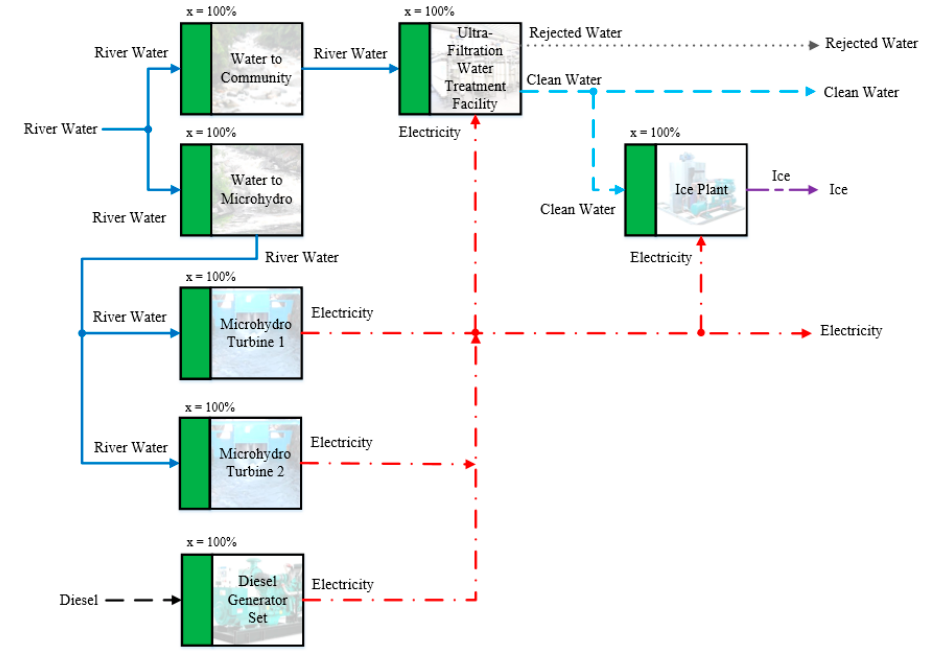
Figure 8. The process flowsheet of the polygeneration system of case study 3. The optimal operational adjustment results for case study 3 using various levels of D is shown in Table 6. The table shows the dynamic operational capacity of the 2 micro-hydro turbines through varying drought intensity levels. It can be observed that turbine 2 will shut off at drought intensity levels of D = 0.40 and 0.50 and will operate again at D = 0.70 and Table 6. The resulting process capacity factor and the optimal production level for case study 3. Optimal Process Scaling Vector, x Drought λ Level, D 0%